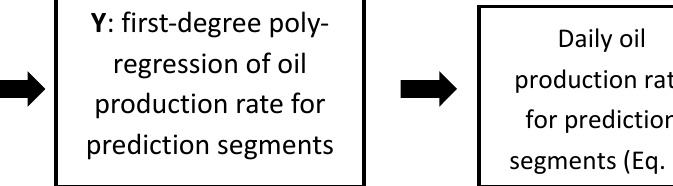
Figure 7. Workflow to predict the surveillance data with the machine-learning tree boosting method and the time-segmented feature extraction.